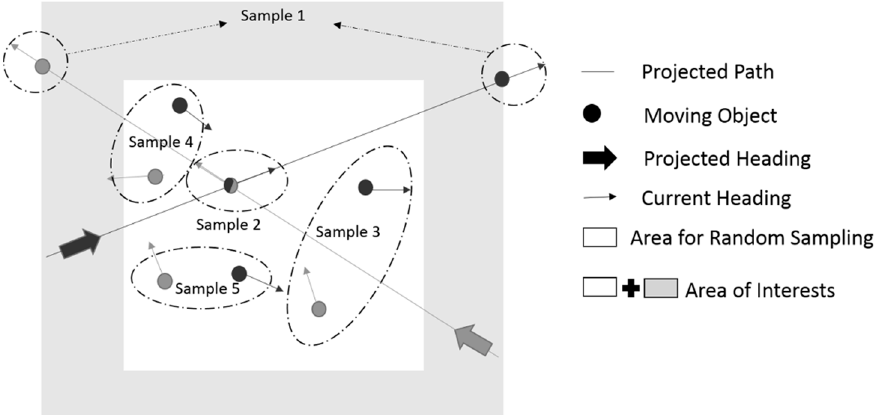
Figure 2. Example sample set.